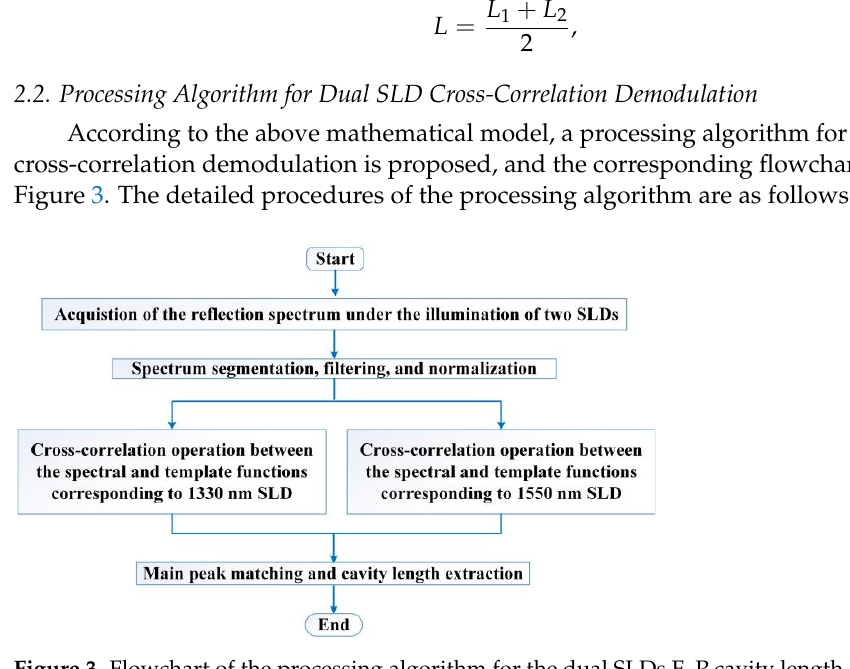
Figure 3. Flowchart of the processing algorithm for the dual SLDs F–P cavity length demodula- tion.